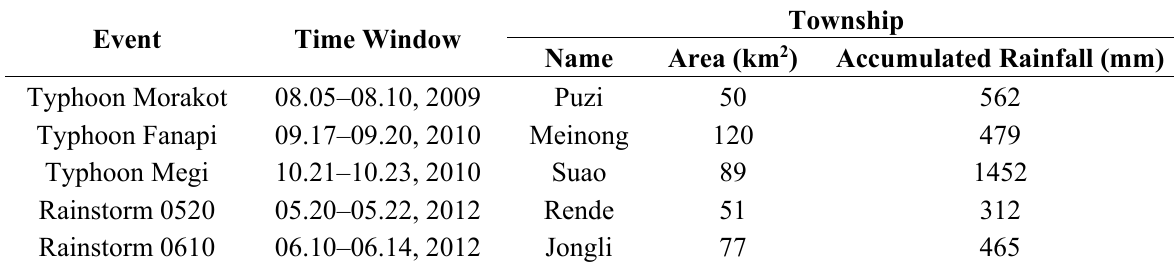
Table 4. Statistics of five special study